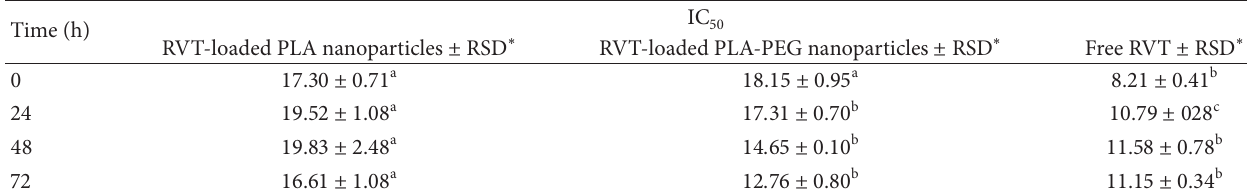
Table 5: IC of RVT (free or nanoencapsulated) over the capture of the ABTS ∙ + cation radical in sodium phosphate buffer (50mM, pH 7.4) 50 and in the absence of light at room temperature ( 𝜆 = 734